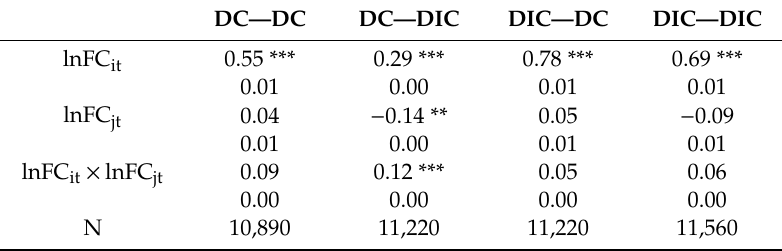
Table 7. Poisson pseudo maximum likelihood (PPML) multilateral-resistance (MR) regression results of country groups. DC—DC DC—DIC DIC—DC DIC—DIC lnFC it 0.55